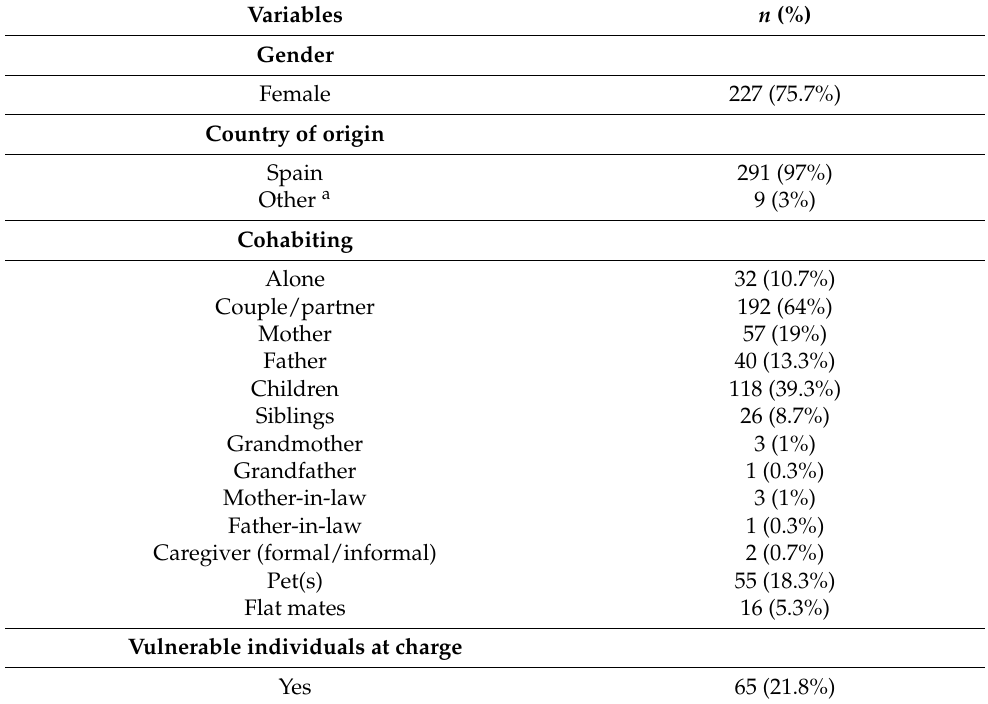
Table 1. Participants’ demographics ( N =